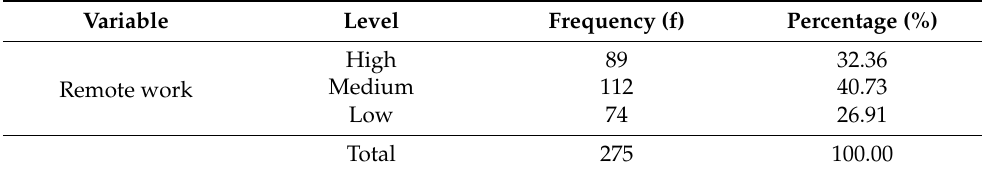
Table 18. Level of the remote work variable in Peruvian workers during COVID-19.